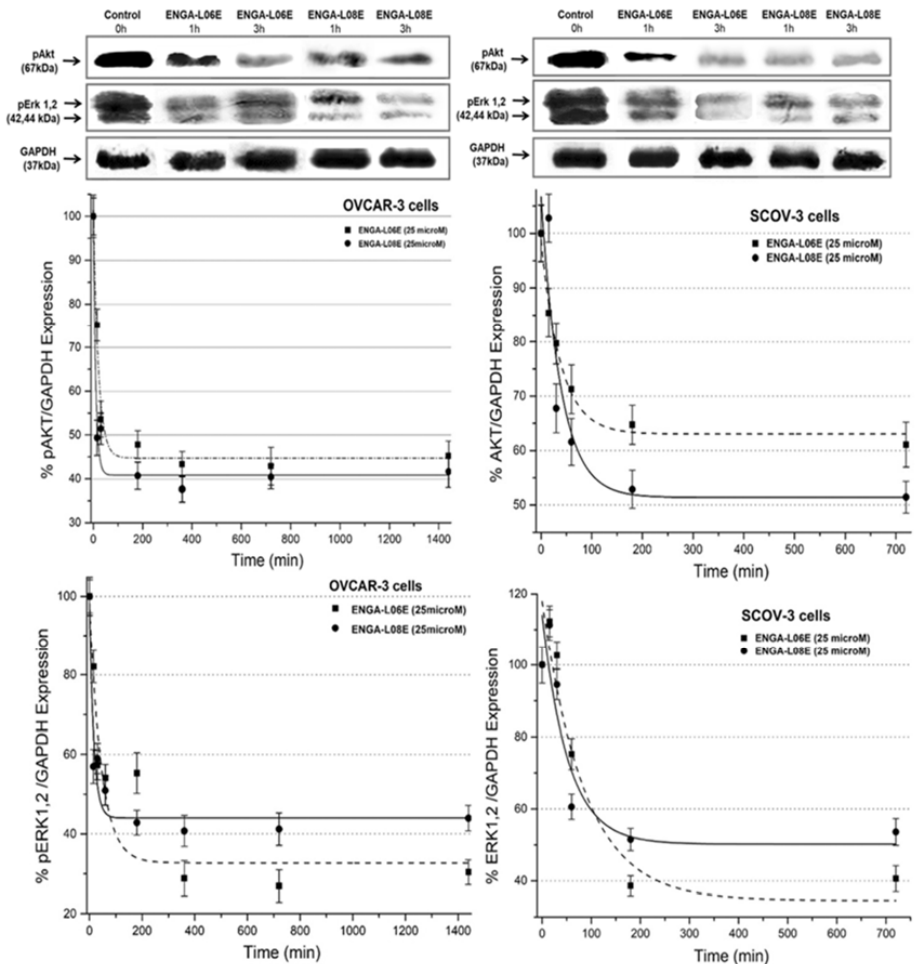
Figure 3. Expression (western blots) and quantification (inhibition curves) levels of ERK1,2 and AKT phosphorylation. Levels of pERK 1,2 and pAKT in SK-OV-3 and OVCAR-3 cell lines after treatment with hybrid aza-steroidal alkylators ENGA-L06E and ENGA-L08E at a concentration of 25 µ M in di ff erent time intervals. Densitometry readings / intensity ratios of expression and quantification data are presented in Figures S1A,B and